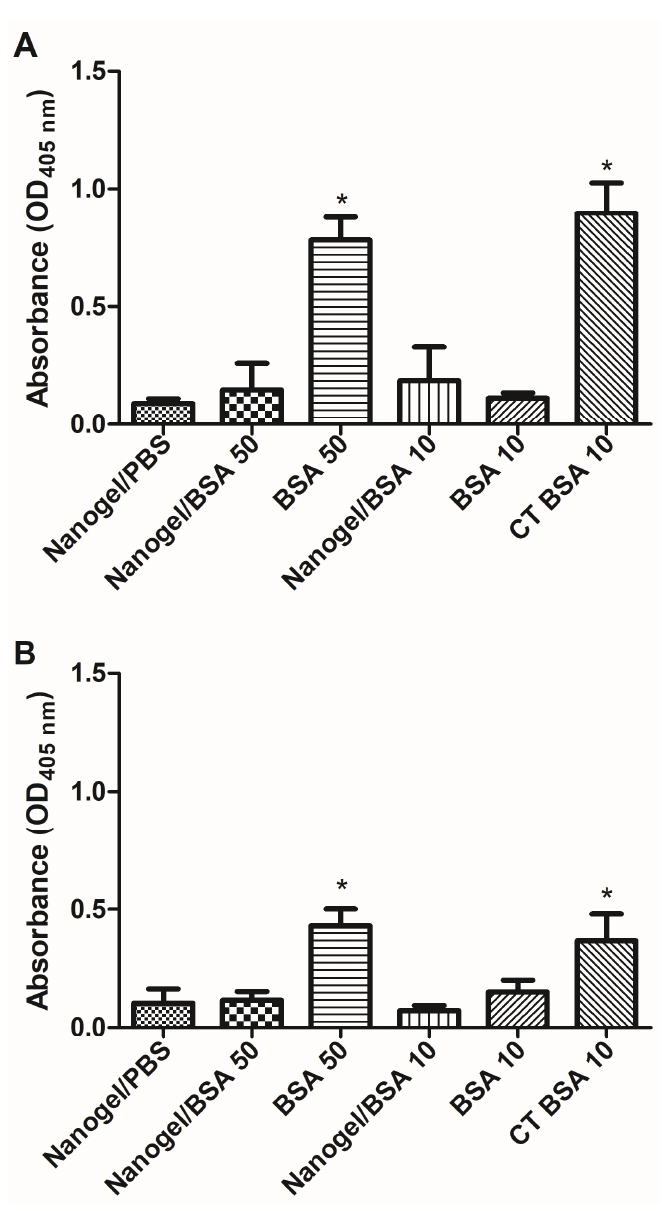
Figure 10. Humoral response analysis induced in test mice upon nasal administration of bovine serum albumin (BSA) soluble or adsorbed in polyacrylic acid/ Schizochytrium sp. (PAA/Schizo) microgels. ( A ) serum anti-BSA IgG or ( B ) nasal washes anti-BSA IgA levels were measured by ELISA in samples from BALB/c mice immunized with soluble BSA at two different doses: 10 or 50 µ g (BSA 50, BSA 10); or embedded in microgels at two doses: 10 or 50 µ g (microgel/BSA 50, microgel/BSA 10). One group received 10 µ g BSA soluble plus Cholera toxin (CT) as an adjuvant. Mice were subjected to a scheme comprising three intranasal (i.n.) doses. Data represent mean ± standard error of the mean (SEM) (n = 4). Statistical differences (* p < 0.05) are indicated by an asterisk (versus the group treated with PAA/Schizo microgels in PBS only).